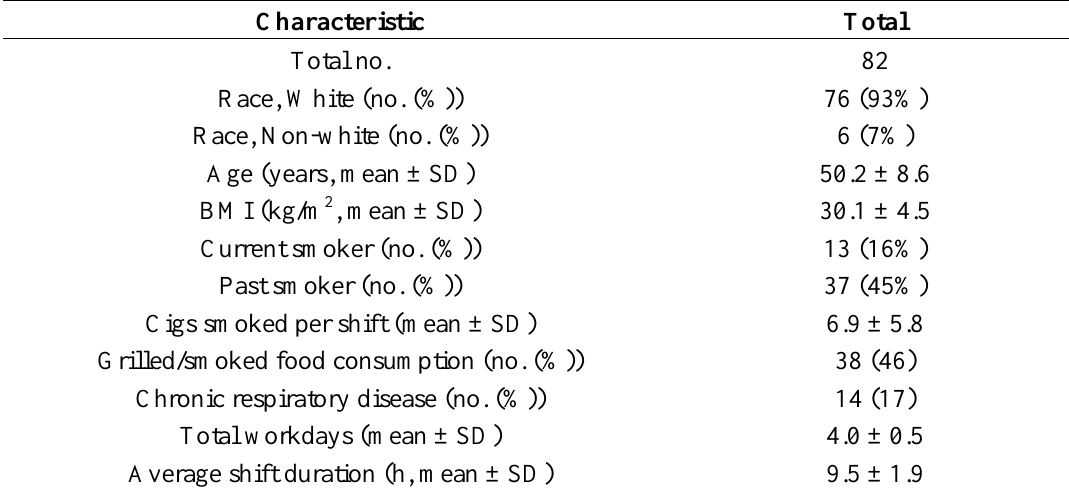
Table 1. Study population characteristics of participating male trucking industry workers.